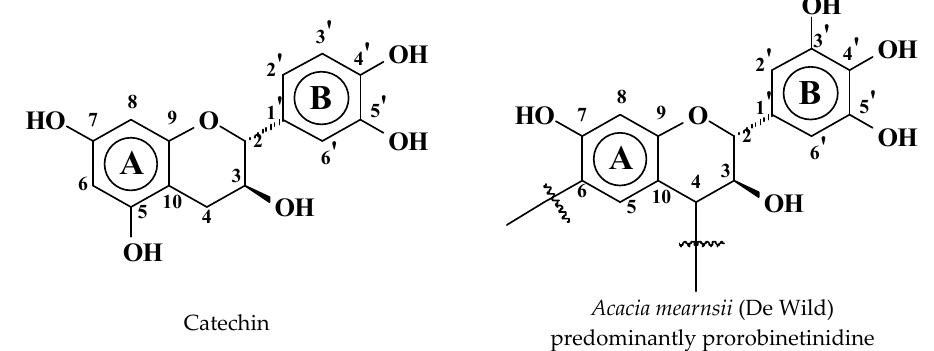
Figure 1. Structure of catechin and structure of the predominant flavonoid unit of mimosa tannin, robinetinidin, with its predominant C4 and C6 sites linked C4–C6 to other flavonoid